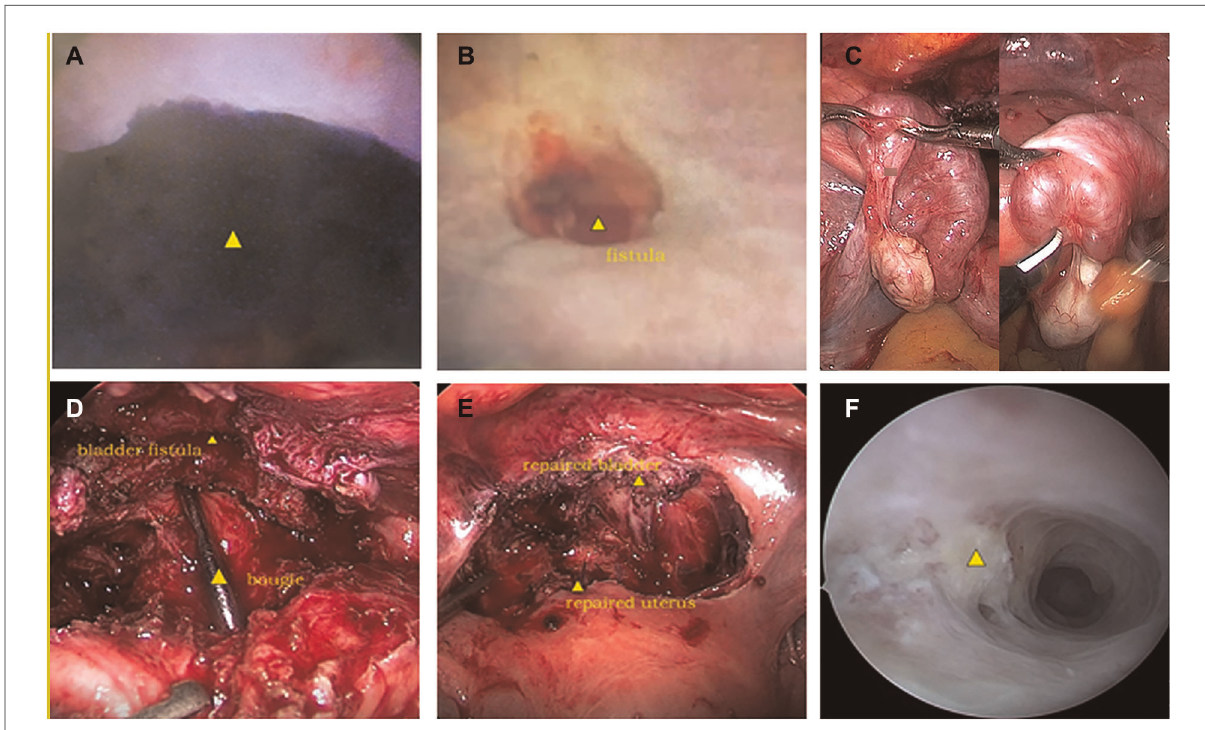
FIGURE 1 ( A ) The fi stulous end of the anterior cervix in hysteroscopy; ( B ) the fi stulous end of the bladder in cystoscopy; ( C ) hematosalpinx of both fallopian tubes in laparoscopy; ( D ) the identi fi cation of the fi stulous end of the cervical and uterine canal by bougie, as well as bladder fi stulous end in laparoscopy; ( E ) the reconstruction of the bladder and the uterus in laparoscopy; ( F ) intrauterine adhesions in